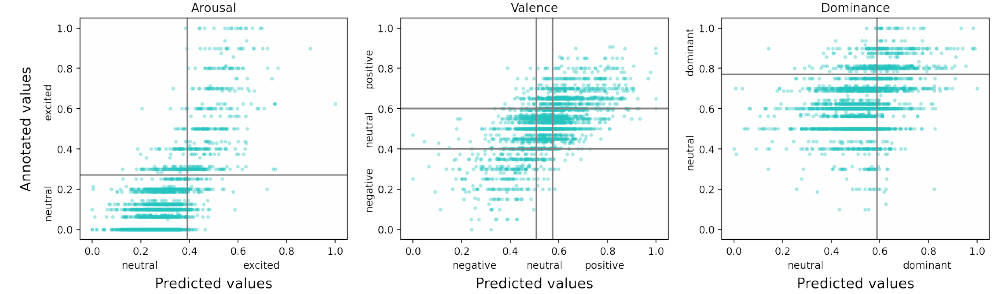
Figure 2. Comparison between the samples annotated by humans and predicted by the network in the dimensional model. Each of the plots depicts a VAD dimension. Each sample is placed at a point based on the actual value of the annotations ( y -axis) and the actual value of the predictions of the network ( x -axis). The lines show how the samples have been separated for the classification problem on each dimension ( y -axis) and how the network has separated them ( x